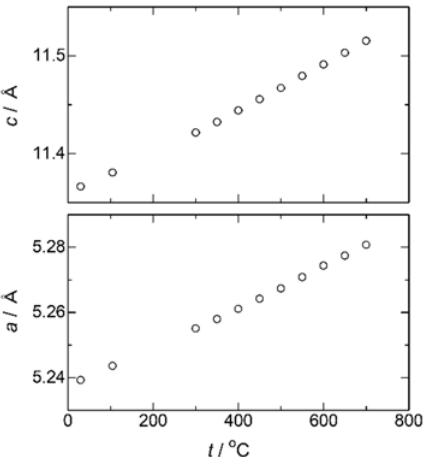
Figure 7. Temperature dependence of the lattice parameters of Ca 1 − x K x WO 4 − x/2 ( x = 0.1).